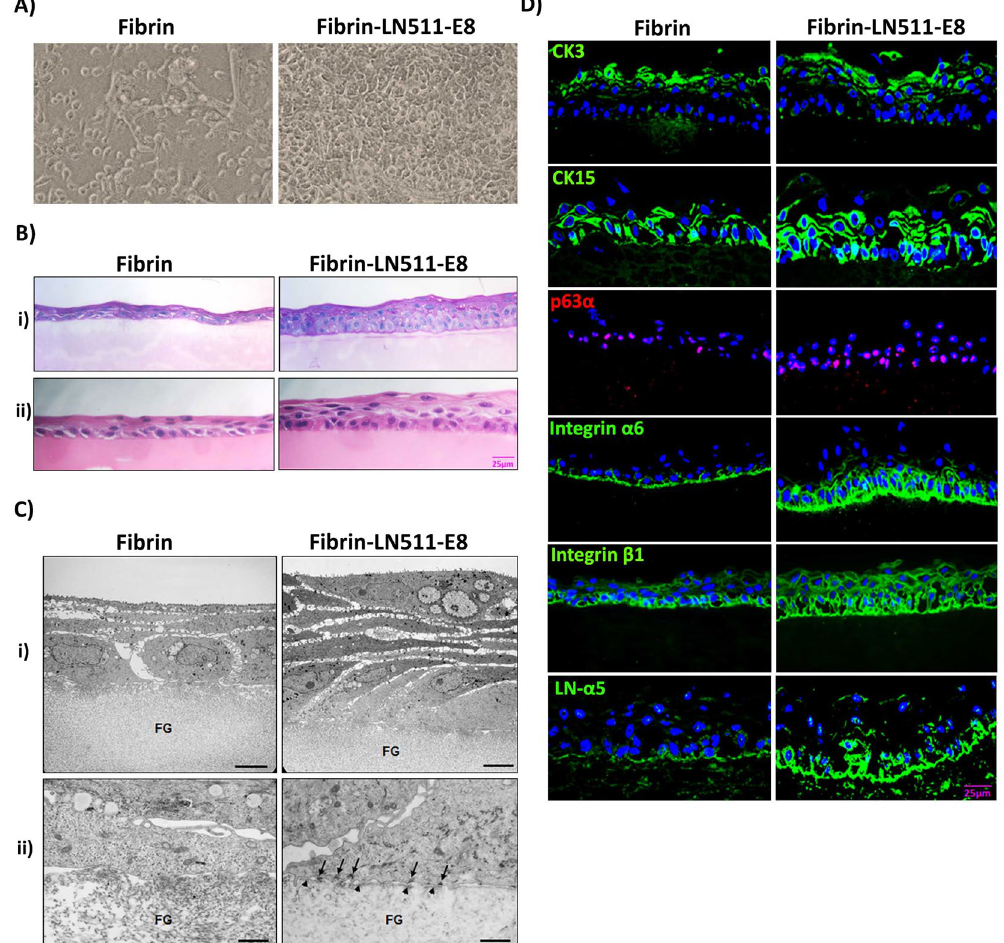
Figure 5. Tissue engineering of corneal epithelial constructs. ( A ) Phase contrast images of limbal epithelial progenitor cells (LEPC) growing on fibrin gels without or with incorporated recombinant laminin (LN)-511-E8 for 5 days (magnification × 100). ( B ) Light micrographs of epithelial cell sheets after two weeks of LEPC culture on fibrin gels without or with incorporated LN-511-E8 (i, periodic acid-Schiff staining; ii, hematoxylin-eosin staining; scale bar = 25 µ m). ( C ) Transmission electron micrographs of epithelial cell sheets after two weeks of LEPC culture on fibrin gels (FG) without or with incorporated LN-511-E8; formation of hemidesmosomes (arrows) and basement membrane (arrowheads) can be seen on LN-511-E8 containing gels (scale bar = 5 µ m in i, and 1 µ m in ii). ( D ) Immunofluorescence analysis of epithelial constructs showing expression patterns of cytokeratin (CK)3, CK15, p63 α , integrin α 6, integrin ß1, and LN- α 5 in epithelial constructs established on LN- 511-E8 containing gels and bare fibrin gels (nuclear counterstaining with DAPI (blue); scale bar = 25 µ